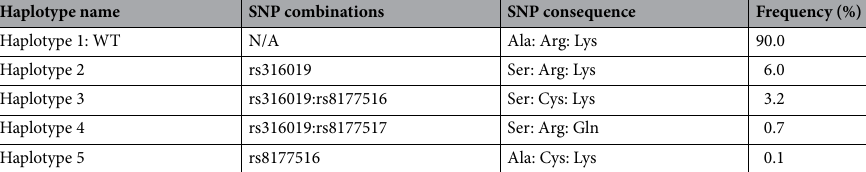
Table 2. Haplotype structure and frequency of SLC22A2 variants in a South African Xhosa population. WT wild type, N/A not applicable. Amino acid abbreviations: Ala alanine, Arg arginine, Lys lysine, Ser serine, Cys cysteine, Gln